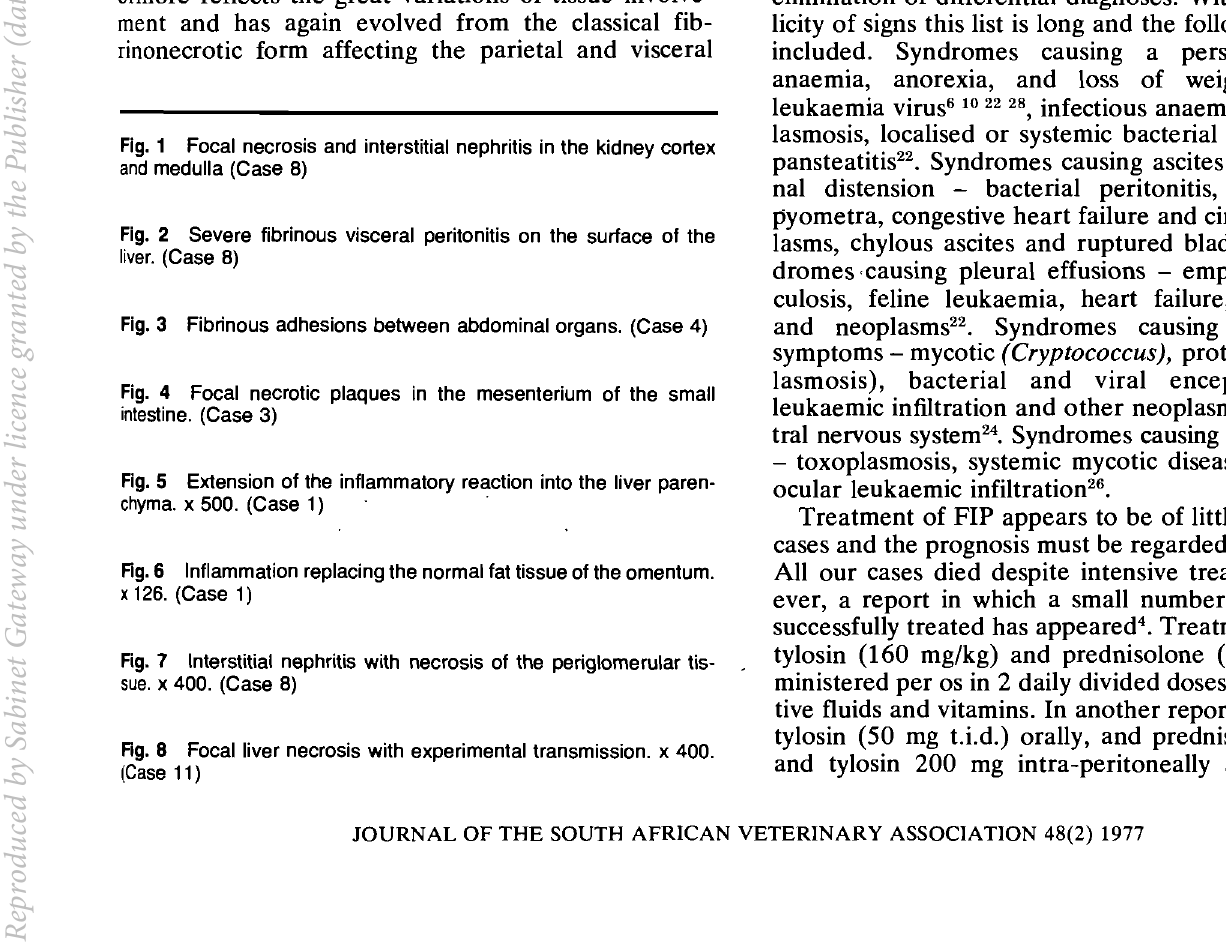
Fig. 1 Focal necrosis and interstitial nephritis in the kidney cortex and medulla (Case 8) Fig. 2 Severe fibrinous visceral peritonitis on the surface of the liver. (Case 8) Fig. 3 Fibrinous adhesions between abdominal organs. (Case 4) Fig. 4 Focal necrotic plaques in the mesenterium of the small intestine. (Case 3) Fig. 5 Extension of the inflammatory reaction into the liver paren- chyma. x 500. (Case 1) . Fig.6 Inflammation replacing the normal fat tissue of the omentum. x 126. (Case 1) Fig. 7 Interstitial nephritis with necrosis of the periglomerular tis sue. x 400. (Case 8) Fig. 8 Focal liver necrosis with experimental transmission. x 400. (Case